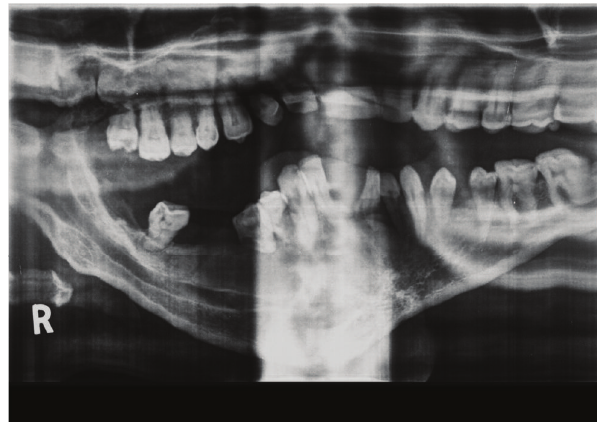
Figure 6: Panoramic radiograph showing widening of the right inferior alveolar canal.